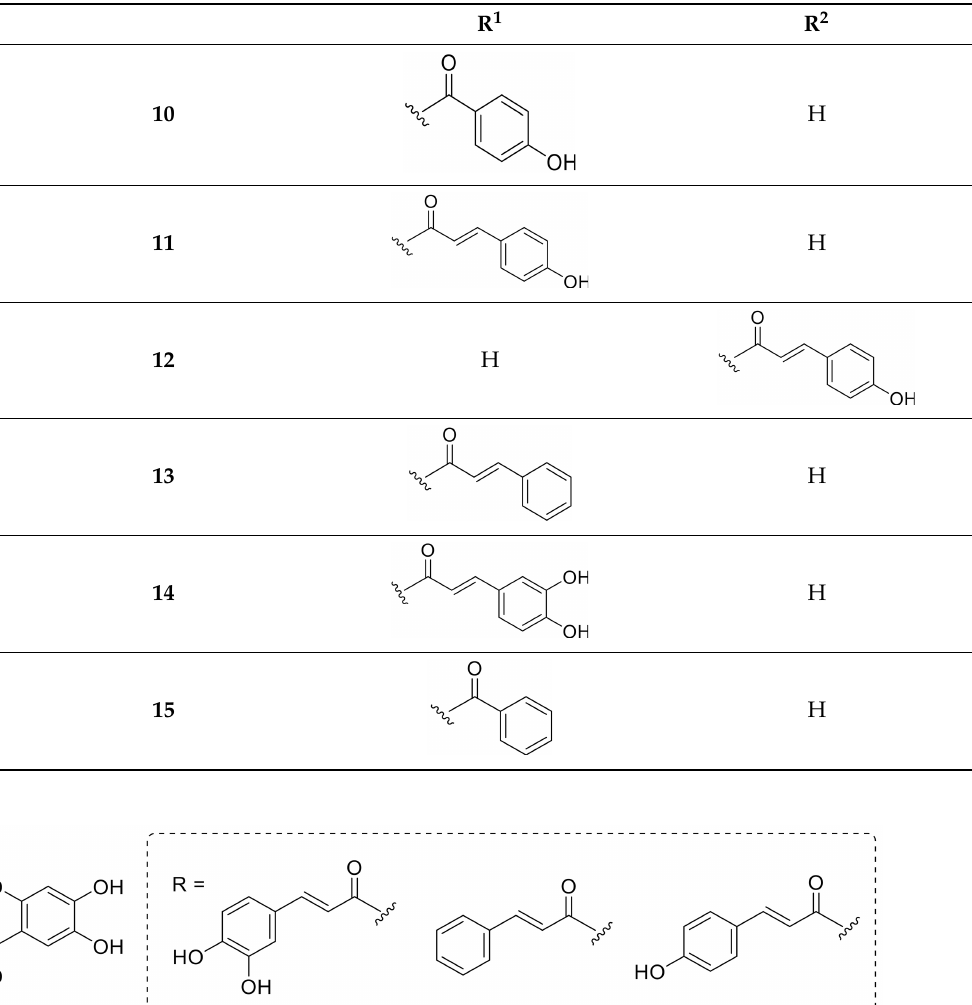
Table 1. The structure of compounds 10 – 15